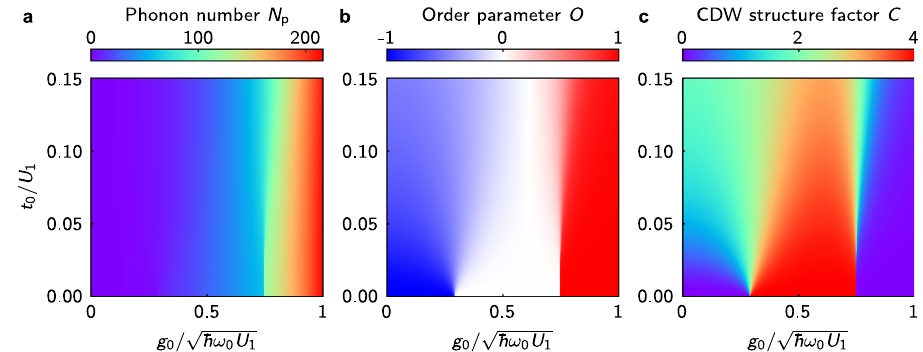
Fig. 5 Equilibrium two-electron states at fi nite hopping t 0 . a The phonon number N p increases as the electron-phonon coupling becomes stronger and is more smooth for a larger t 0 . b , c The order parameter O and CDW structure factor C get reduced, but the three equilibrium regimes discovered in the atomic limit still survive under small but fi nite t 0 . Here we set U 1 /2 π ℏ = 200 GHz, U 2 /2 π ℏ = 20 GHz, U 3 /2 π ℏ = 2 GHz, and ω 0 /2 π = 3 GHz. The local chemical potential ε is ignored for the two-electron case, and the bias voltage is set to zero for these